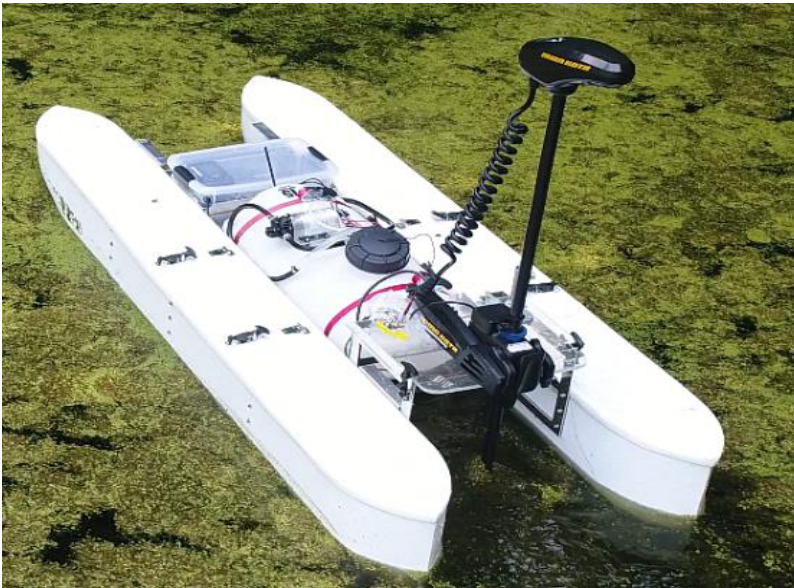
Figure 5. Autonomous boat prototype for identification and chemical treatment of invasive aquatic plant species.